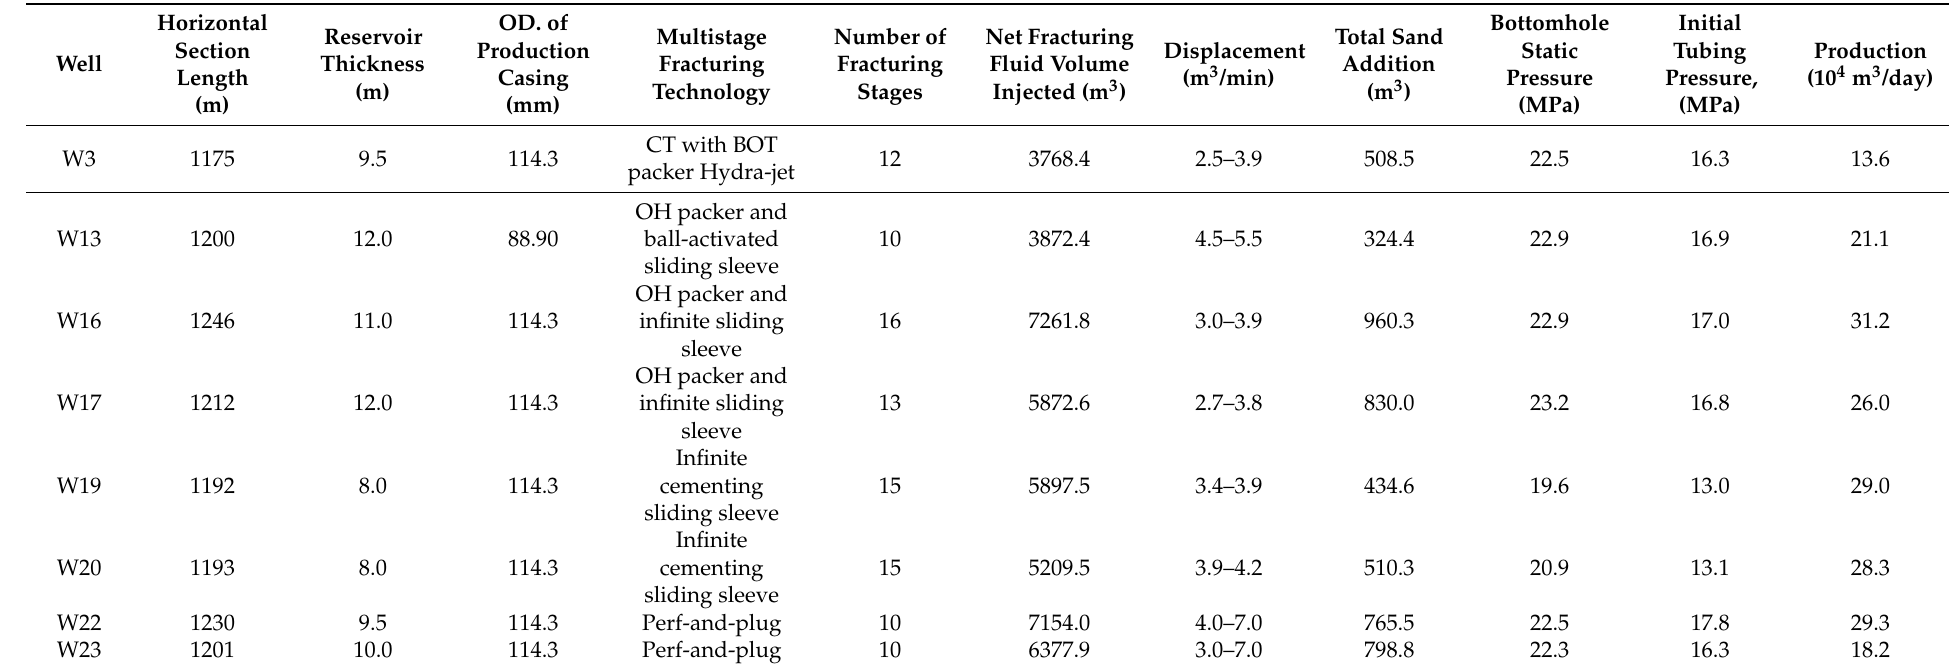
Table 7. Parameters and production of Class I horizontal wells in Block